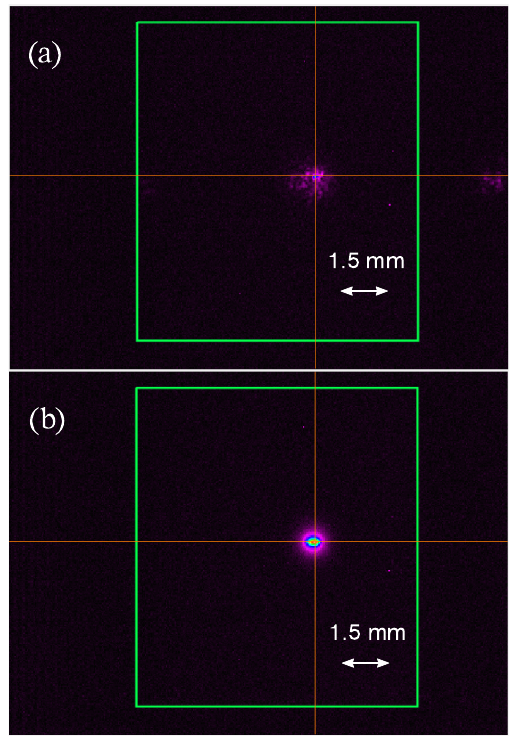
FIG. 22. Snapshots of the screen monitor located at the IP. (a) shows the laser profile without an electron beam. (b) shows the electron beam